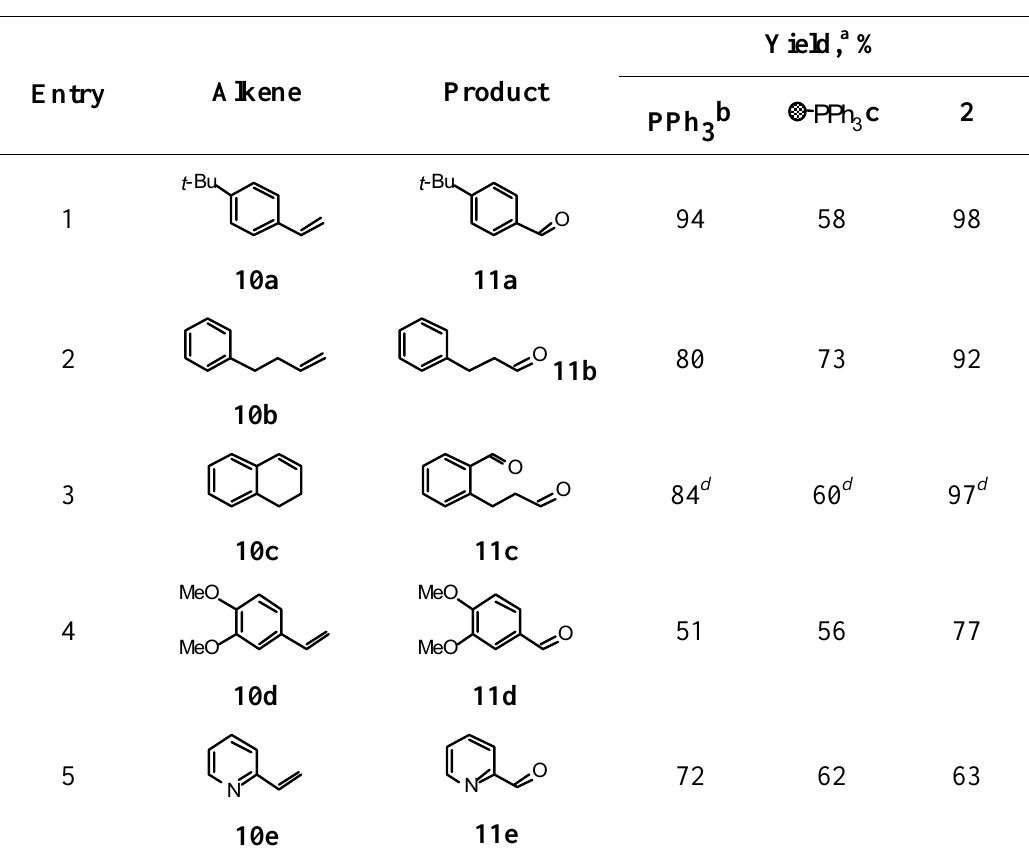
Table 1. Direct comparison of ozonide hydrolysis between solution-phase, solid-phase and liquid-phase